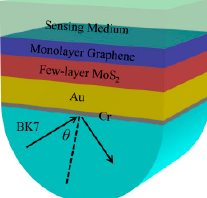
Figure 1. Schematic illustration of the designed SPR sensor.